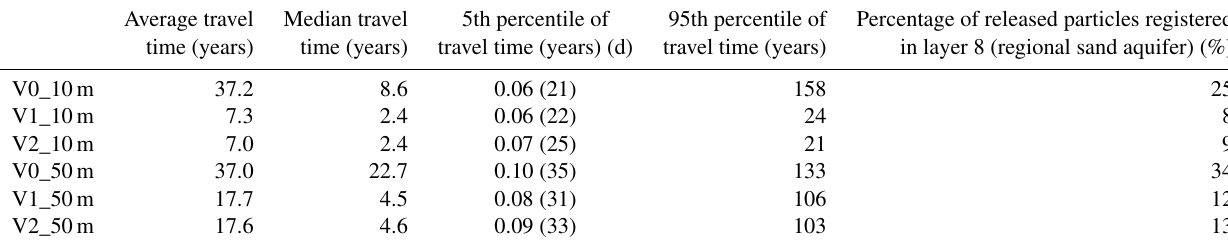
Figure 12. The 95th percentile of the simulated water table depth. Table 5. Statistics on simulated particle tracking for particles reaching